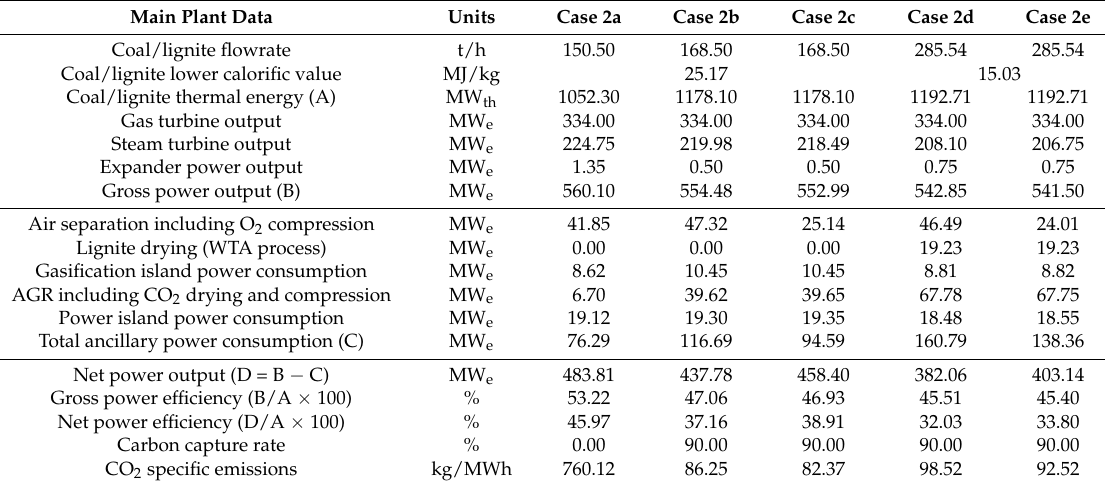
Table 3. Overall coal and lignite IGCC power plant technical